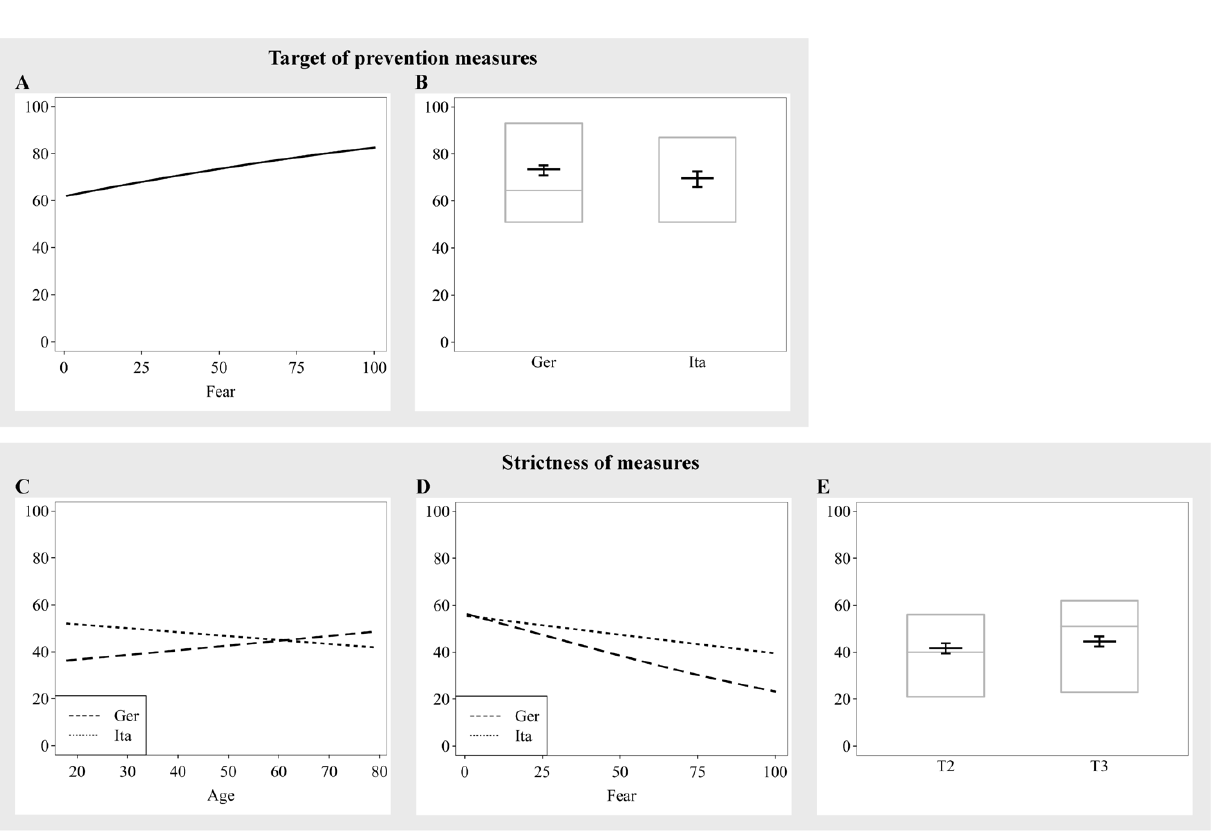
Figure 3. Estimates of the significant main effects and interactions for the ratings of the moral scenarios that were presented in assessment periods 2 and 3. ( A , B ) Target of prevention measures; ( C – E ) Strictness of measures.